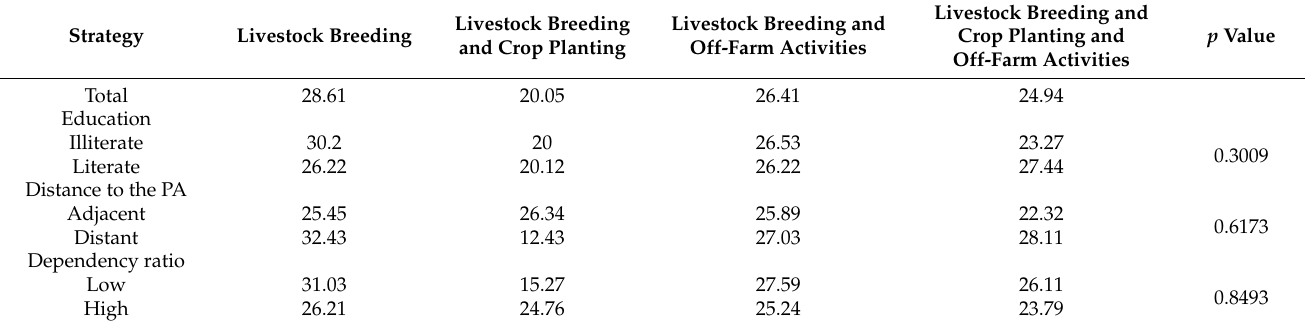
Table 2. Proportion of households around MMNR adopting different livelihood strategies